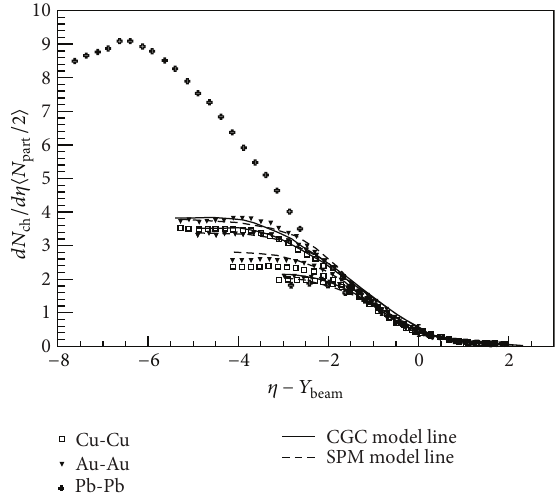
Figure 19: Charged hadron pseudorapidity density per participant at RHIC and LHC energies for different pair as a function of 𝜂−𝑌 beam colliding systems. Data are taken from [122,